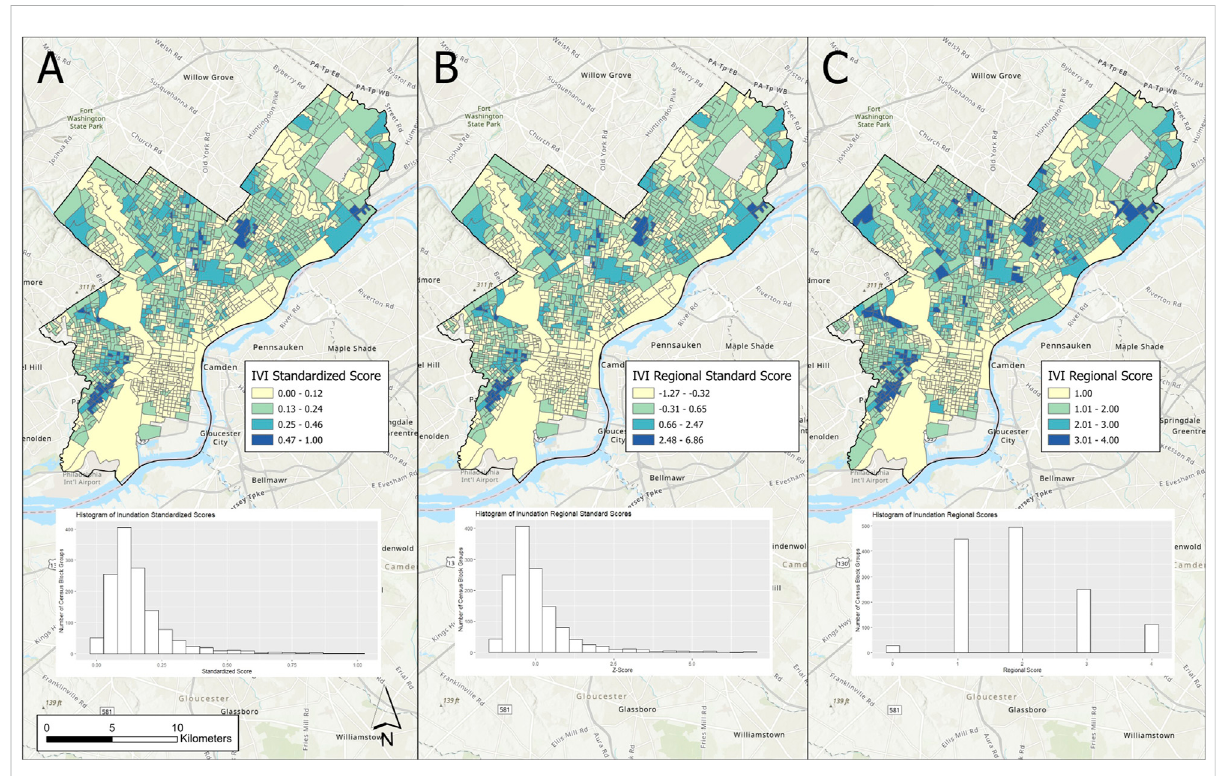
FIGURE 2 The analysis of the Inundation Vulnerability Index results. (A) The spatial distribution of the IVI based on the standardized scoring method. (B) ThespatialdistributionoftheIVIbasedonthez-scores. (C)